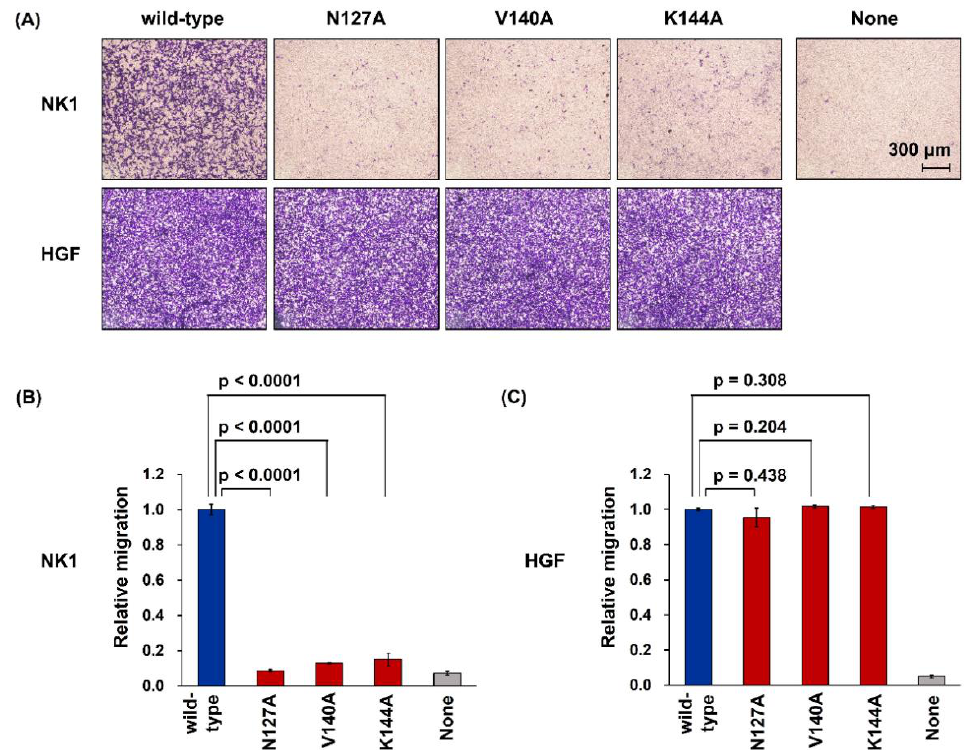
Figure 4. Cell migration induced by wild-type and mutant NK1 ( A , B ) and HGF ( A , C ). B16F10 cells were cultured in the absence or presence of 35 nM NK1 or 0.2 nM HGF for 20 h. In A, representative images of the migrated cells on the bottom side of the membrane after crystal violet staining are shown. In B and C, quantification of migrated cells is shown. Cell migration levels induced by wild-type NK1 or HGF were set to 1.0. Data are mean ± s.e.m. ( n = 3, distinct replicates for cell cultures, unpaired two-tailed t-test). This experiment was repeated twice independently with similar results.